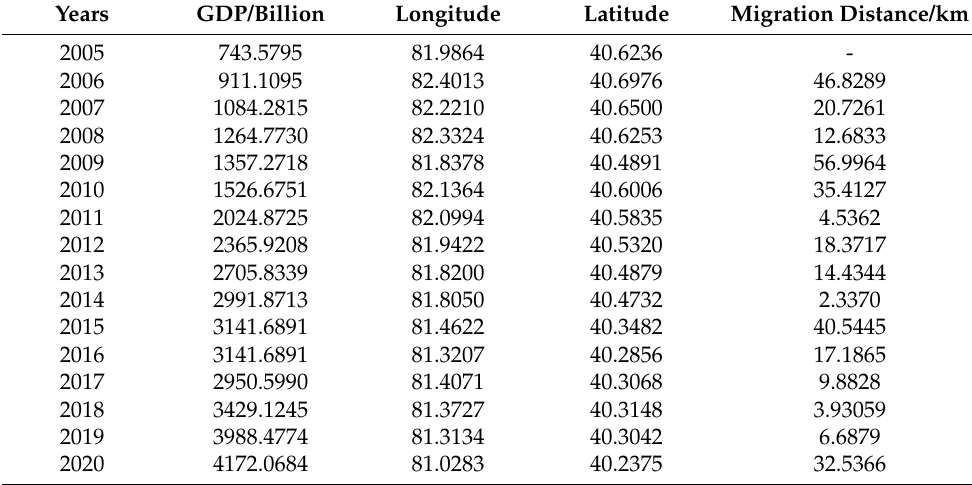
Table 2. GDP, center of gravity coordinates, and migration distance in the Tarim River